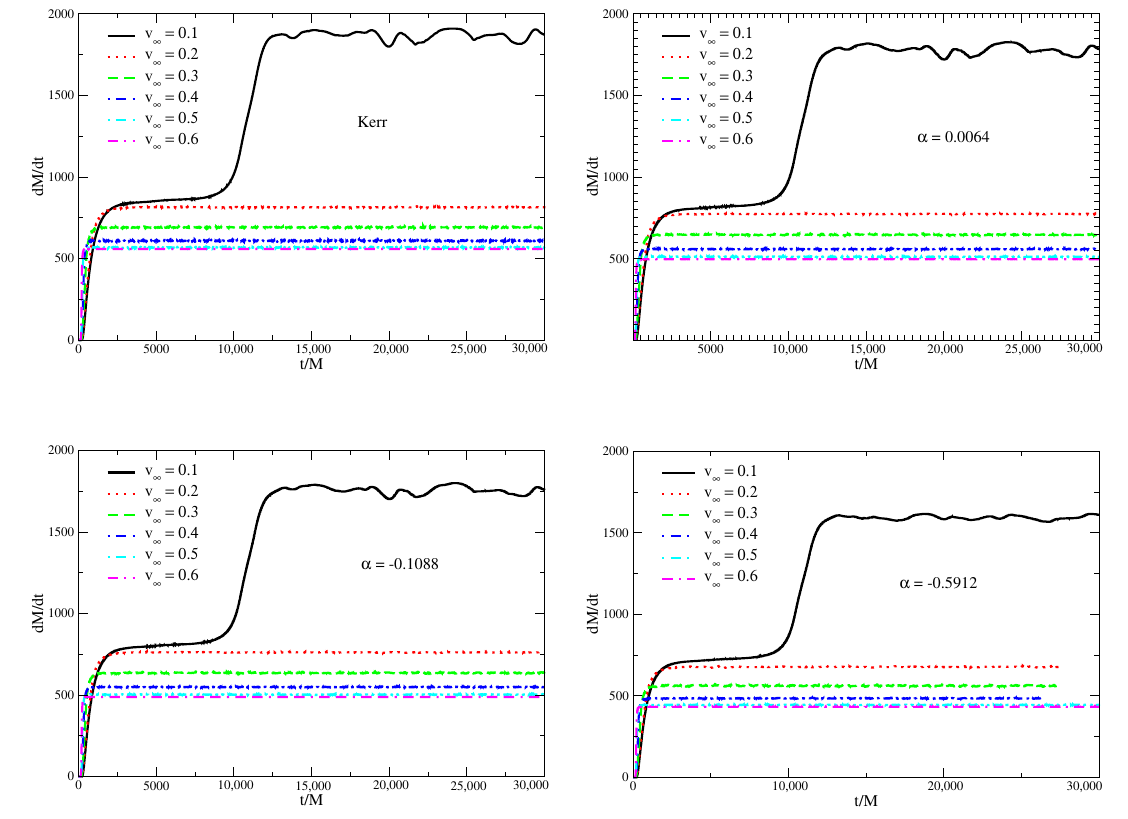
Figure 6. Mass-accretion rate versus time for Kerr and EGB black holes.